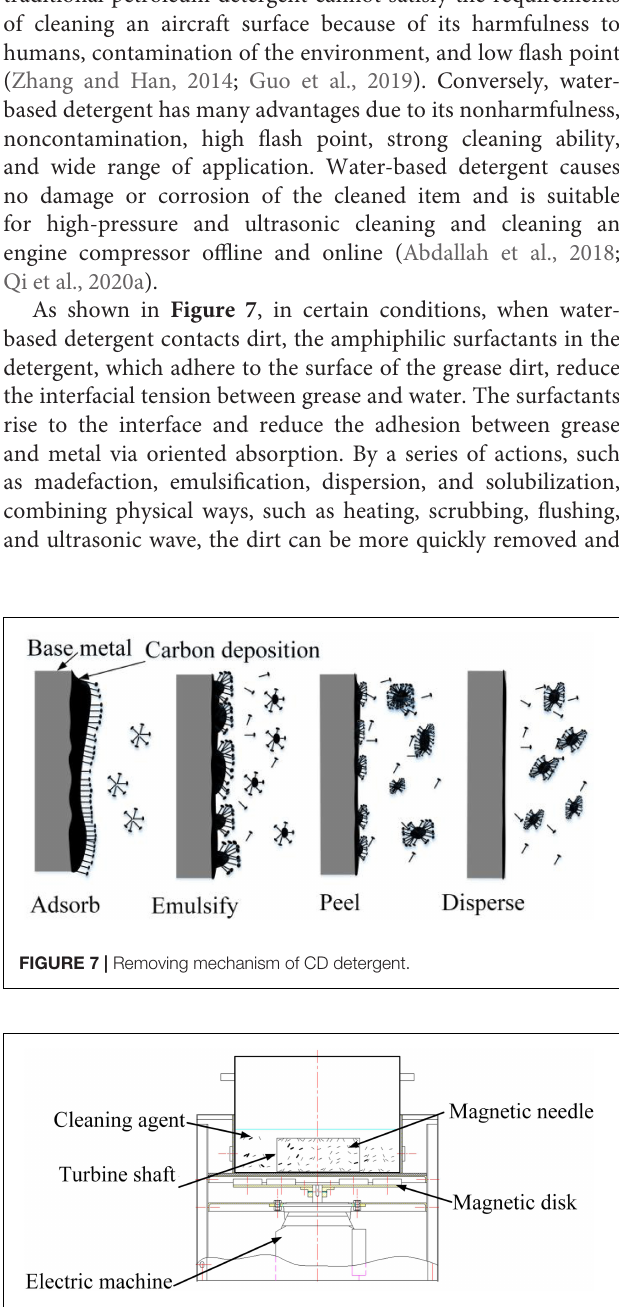
FIGURE 8 | Processing